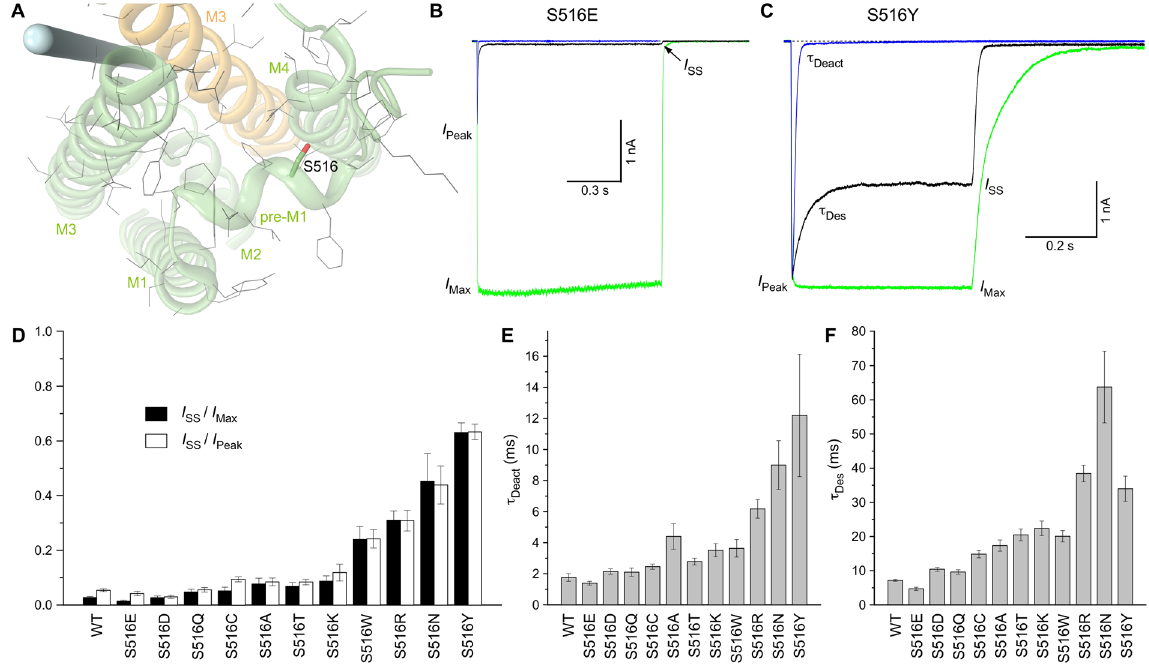
Figure 2. Substitutions of serine S516 with different amino acids. ( A ) Close-up view of the region encompassing noncompetitive inhibitor binding site, with S516 shown as thick (green and red) and other residues thin (grey) sticks. The pore axis is illustrated by a blue cylinder. ( B , C ) Representative superpositions of whole-cell currents recorded at − 60 mV membrane potential from HEK293 cells expressing GluA2-S516E ( B ) and GluA2-S516Y ( C ) in response to 2 ms (blue) or 1s/500 ms (black) applications of 3 mM Glu alone or application of Glu in the continuous presence of 30 µ M CTZ (green). ( D–F ) The average values of fractions of non-desensitized channels, I SS / I Max and I SS / I Peak ( D ) and time constants of deactivation, τ Deact ( E ) and desensitization, τ Des ( F ) for wild type GluA2 and mutant receptors. Error bars represent